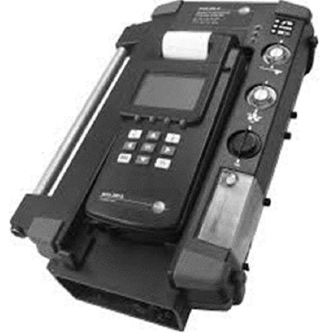
Figure 4. Gas analyzer TESTO 350 XL .